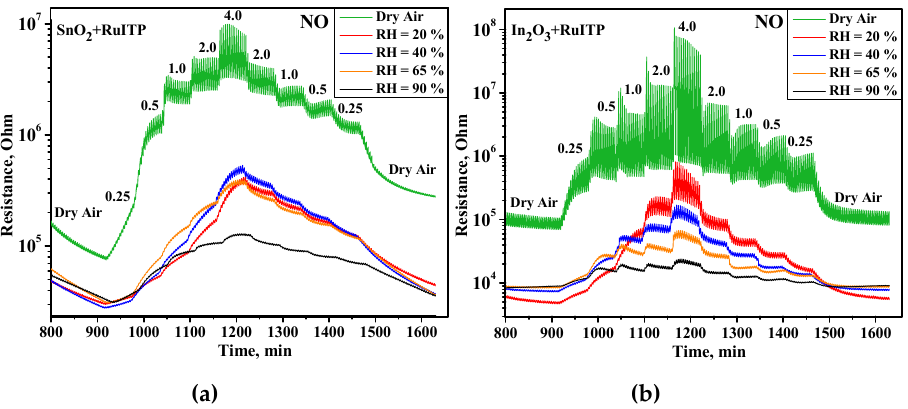
Figure 1. Room temperature electrical resistance change of the ( a ) SnO 2 +RuITP and ( b ) In 2 O 3 +RuITP hybrid materials under periodic illumination during stepwise increase and decrease of the NO concentration in dry air and humid air.